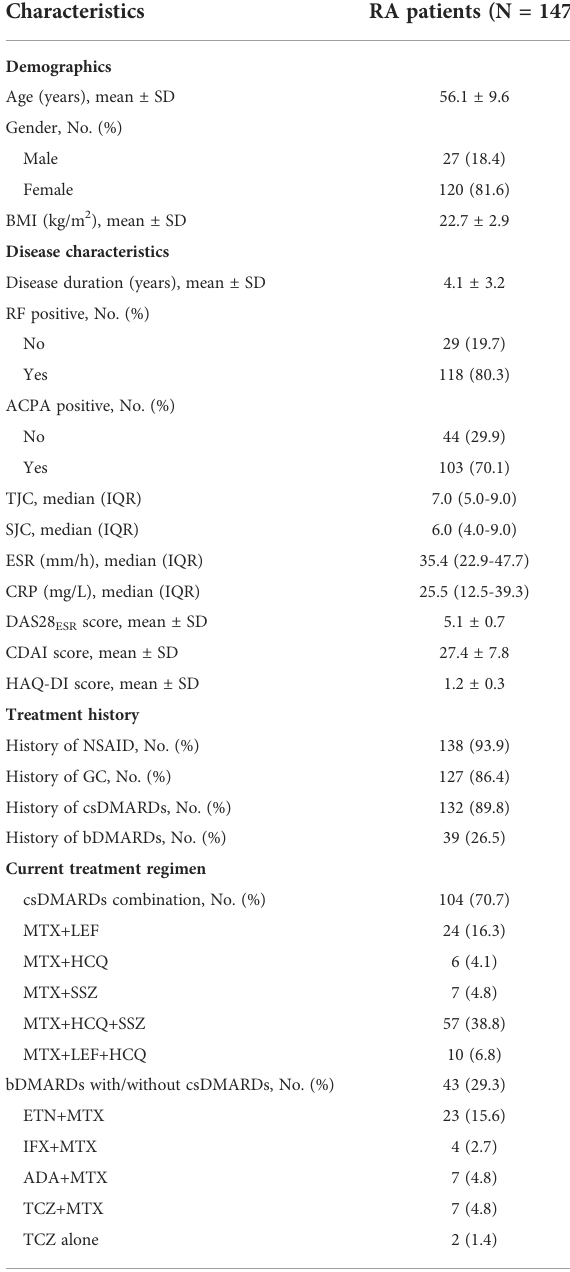
TABLE 1 Clinical characteristics of RA